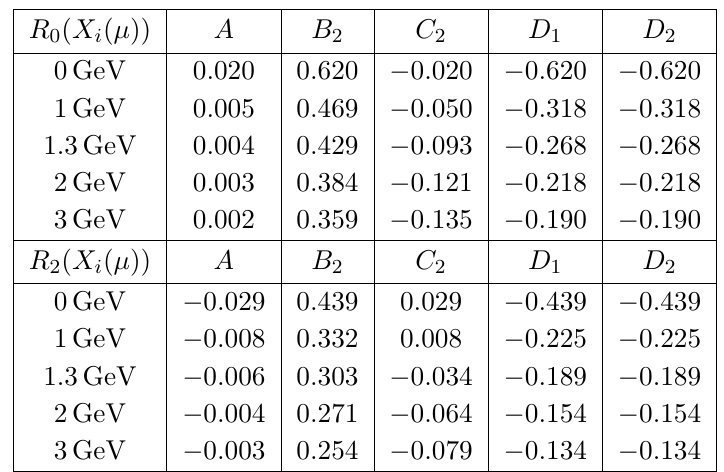
Table 6 . Ratios R I of BSM operators in the DQCD basis allowed by SMEFT over ^ Q 8 contributing to the isospin amplitudes A 0 ; 2 for four values of (cid:22)